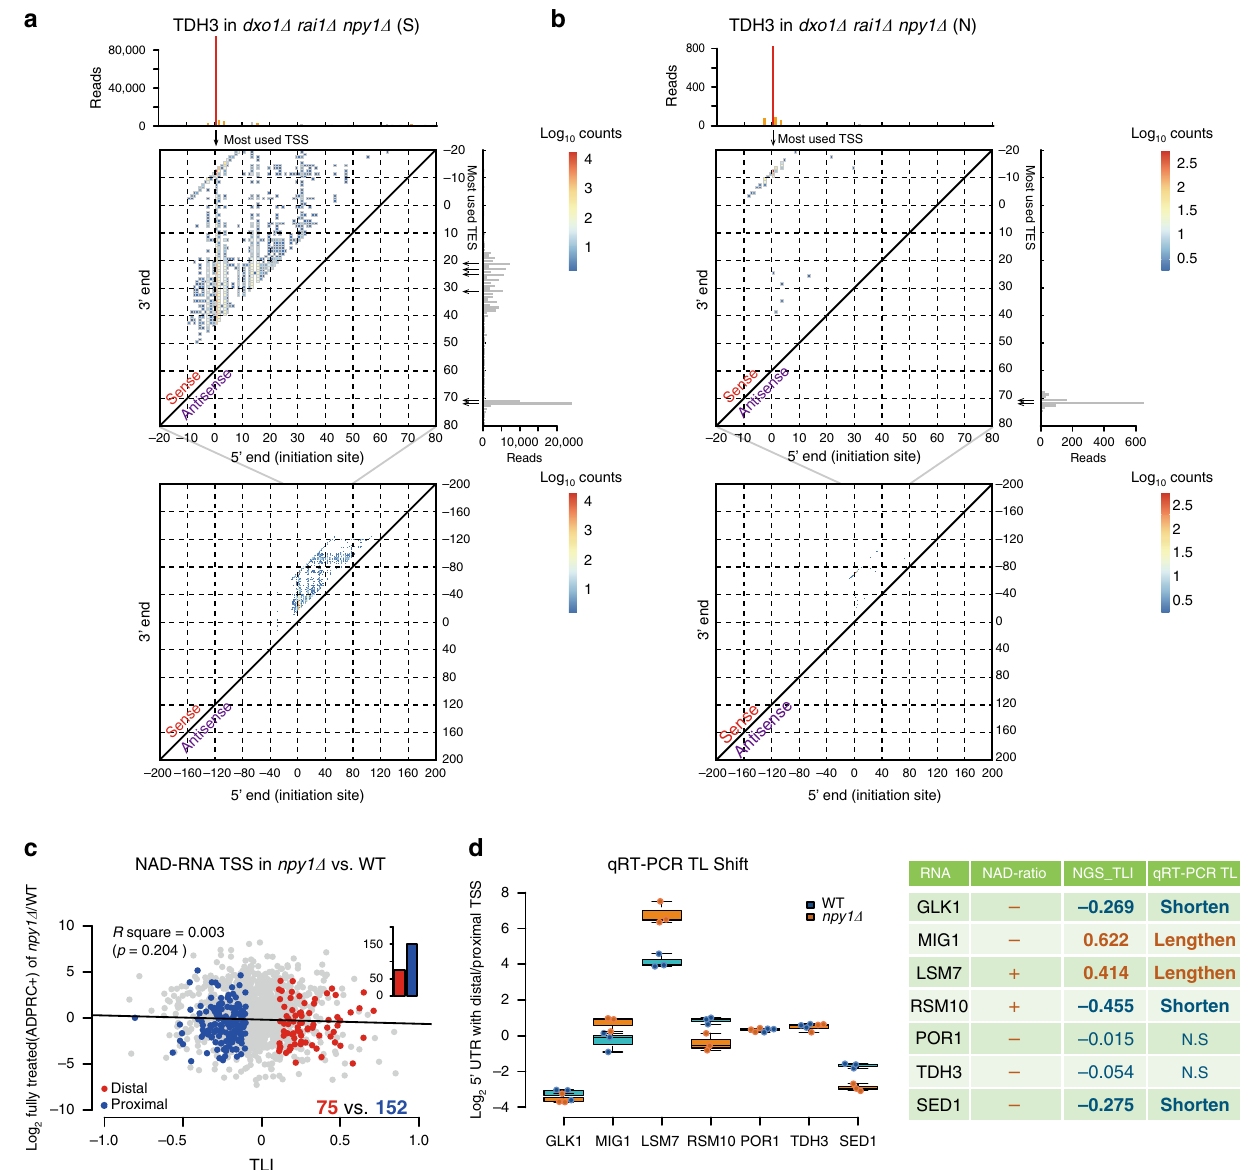
Fig. 8 The 5 ′ - and 3 ′ - end heterogeneity of NAD-RNA. a , b 2D NAD-capping single transcript plot for TDH3 RNA in the dxo1 Δ rai1 Δ npy1 Δ strain for the sample group ( + ADPRC, S, ( a )) and the N group ( − ADPRC, N, ( b )). 0 denotes the RefSeq TSS ( − 39 nt of the TLS site). Each bin represents a unique 5 ′ (initiation site, TSS, x axis) and 3 ′ (transcript end site, TES, y axis) pairing colored by the number of reads mapped to that bin. Expanded view below. For the 5 ′ -end initiation site histogram (above the 2D plot), the red bar indicates the “ A ” position with YAAG feature, whëreas orange bars indicate “ A ’ s ” without this feature and gray bars indicate U/C/G. For the 3 ′ -end histogram, no color differentiation was performed. Arrows represent preferred TSSs in the 5 ′ - dimension and TESs in the 3 ′ -dimension. c Global effect of the deletion of the NPY1 gene on the transcript leader length by comparing NAD captureSeq read starts in the npy1 Δ mutant with the WT (unfragmented libraries). A Transcript Leader length Index (TLI) > 0 indicates that upon npy1 Δ mutation the TSS towards more distal positions, while a TLI < 0 indicates a proximal shift; RNAs with signi fi cantly (FDR < 0.05) shifted TSS are shown as colored dots. Red: distal shift (TLI > 0.1) Blue: proximal shift (TLI < − 0.1). The y axis indicates the relative NAD-RNA enrichment difference (ratio) from NAD captureSeq libraries between the two strains. The bar charts represent the total number of RNA species with distal (red) or proximal (blue) TSS shift. d qRT-PCR with different primer pairs con fi rming different NAD-RNA transcript leader (TL) lengths in the enriched fractions from NAD captureSeq libraries between WT (blue boxes) and npy1 Δ strain (orange boxes). All parameters and the layout of boxplot are as in Fig. 6d. In the table, symbol “ − ” and “ + ” indicate a decrease or increase of the NAD-modi fi cation ratio, respectively. “ NS ” indicates no signi fi cant difference. Source data are provided as a Source Data fi